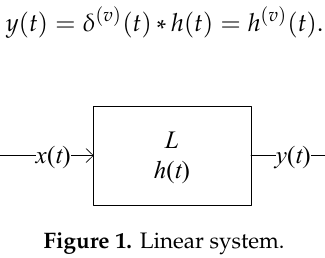
Figure 1. Linear system.